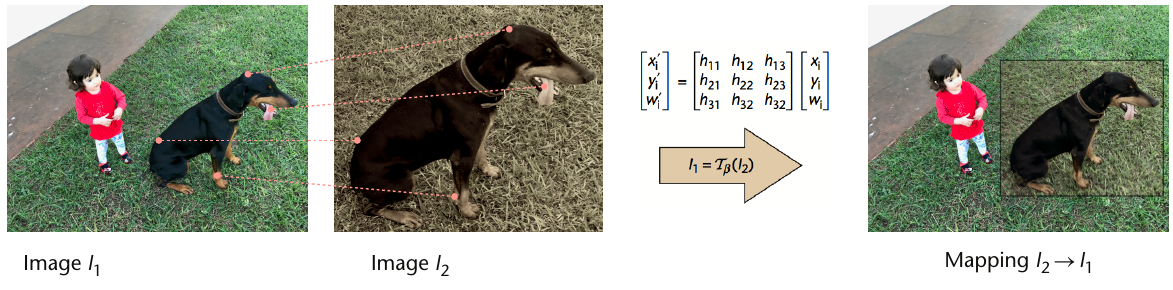
Figure 1. Image phylogeny tree construction process. To calculate image dissimilarities between a pair of images I 1 and I 2 , we find Figure 9 - Image mapping process: to calculate the dissimilarity between images I 1 and I 2 , robust points of interest are computed. robust points of interest in both images, and for those which are good matches (yellow stars), we calculate an homography matrix Then, an homography matrix is calculated to enable pixel-by-pixel comparison and, therefore, the dissimilarity matrix. Adapted representing the necessary parameters to transform one image to another’s domain. Once we perform the mapping, we can compare from (Dias et al. both images pixel by pixel within the region of interest they overlap.